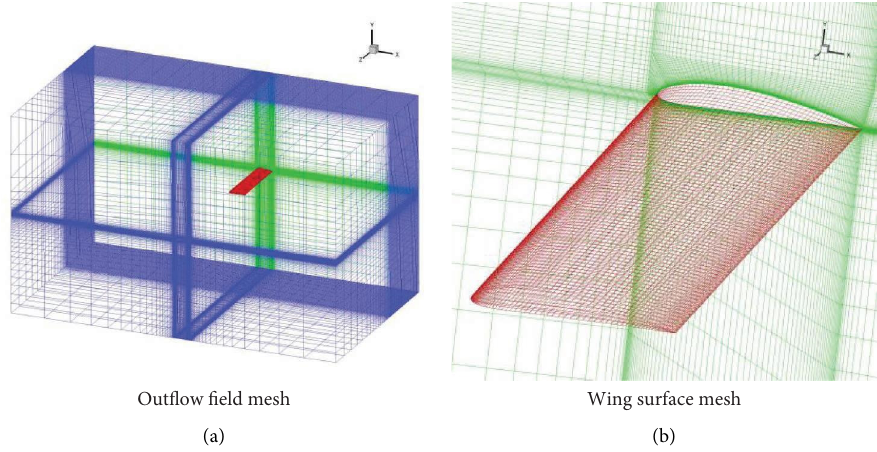
Figure 5: Flow feld computing grid: (a) outfow feld mesh; (b) wing surface mesh.